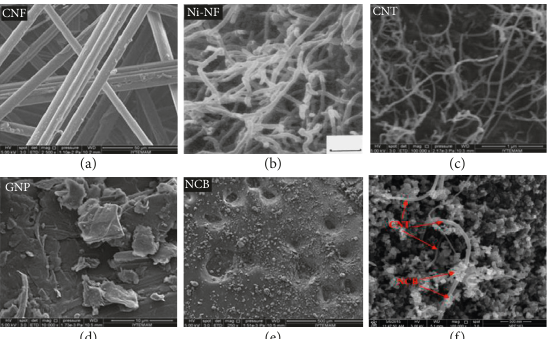
Figure 16: SEM photos of (a) CNF [89]; (b) Ni-NF [90]; (c) CNT [89, 91]; (d) GNP [89]; (e) NCB [89]; (f) CNT/NCB